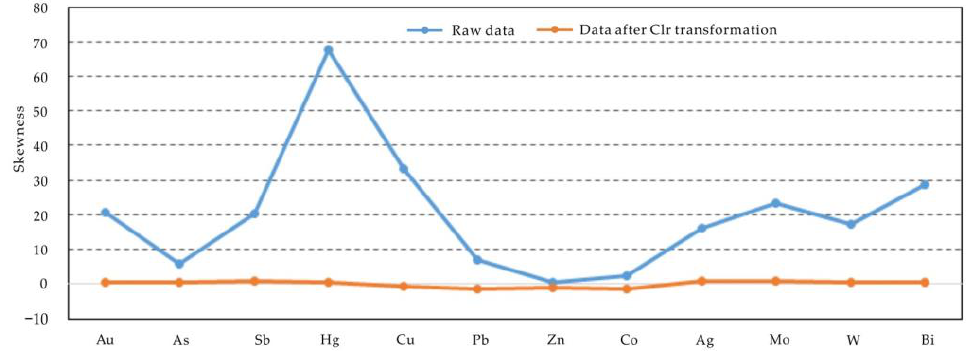
Figure 11. Comparison of the skewness values of elemental data before and after clr transformation.